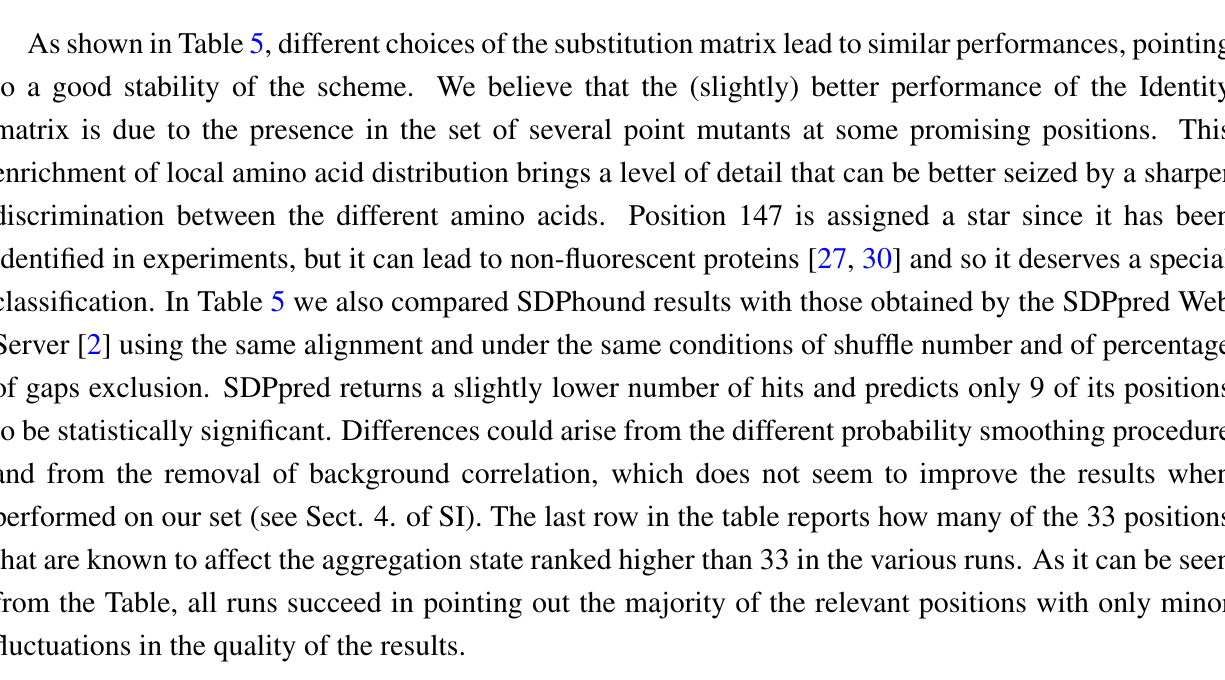
Table 6. Substitution class based runs over SPDs relevant for multimerization in IFPs family. Ranking and colors as in Table